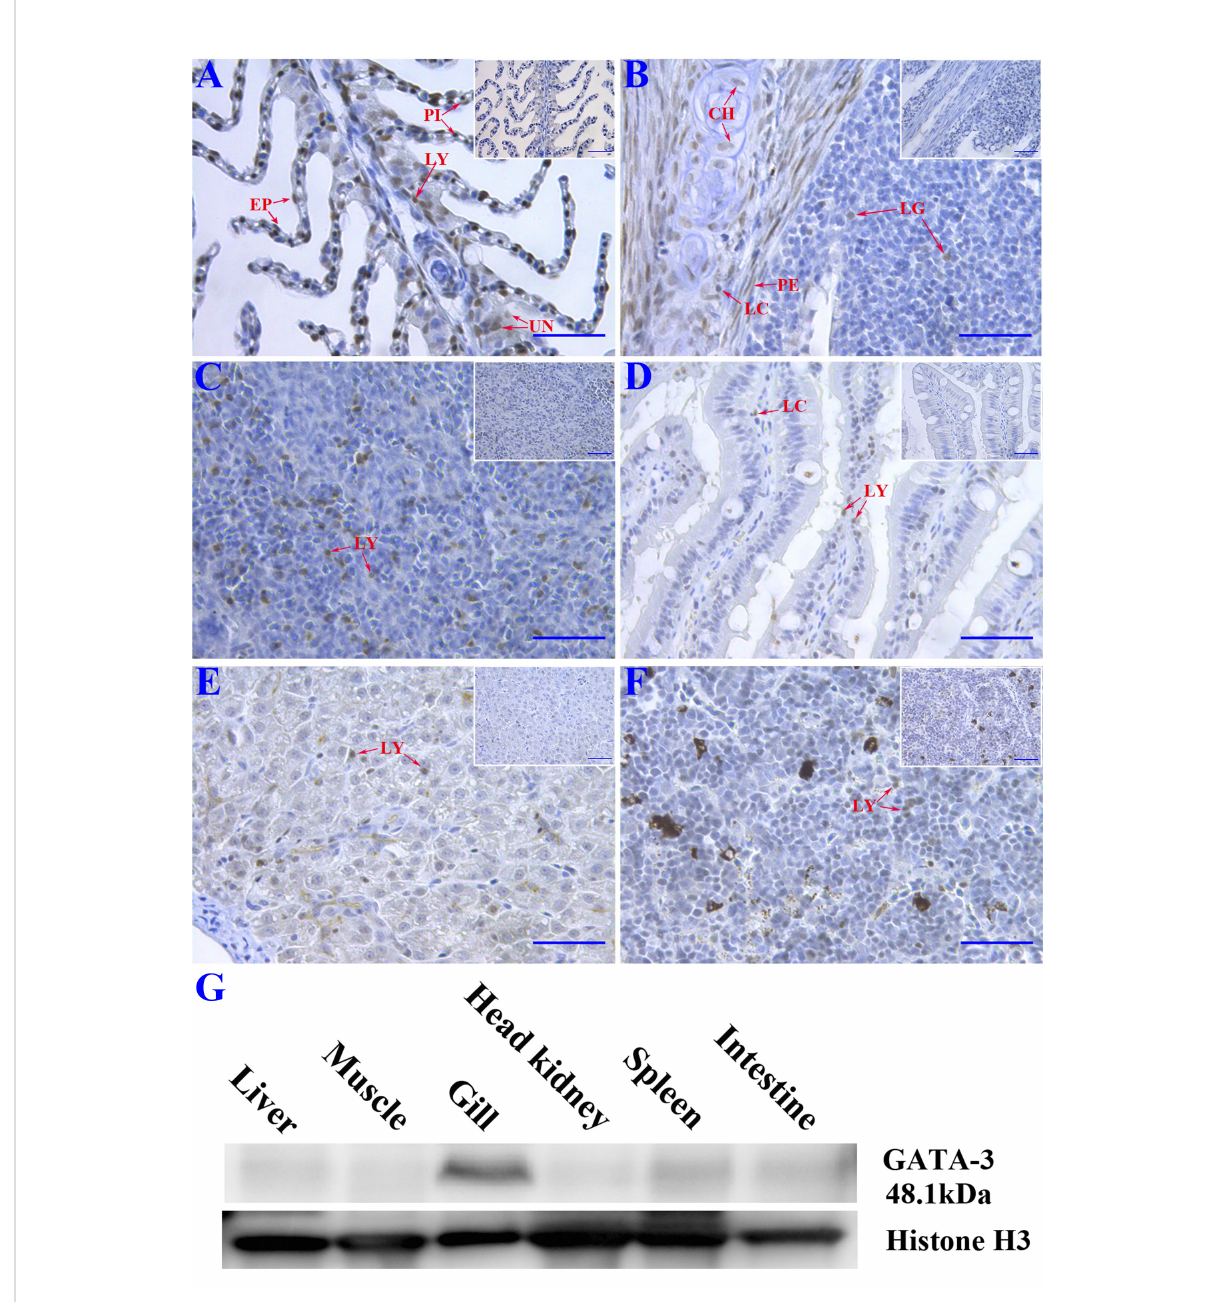
FIGURE 2 Immunohistochemistry study of the distribution of SsGATA-3 proteins in gills (A) , gill-associated lymphoid tissue (GIALT) (B) , spleen (C) , intestine (D) , liver (E) , and head kidney (F) . PI: pillar cell; LY: Lymphocyte-like cell; EP: Epithelial cell; UN: undifferentiated basal cell; CH: chondrocyte; LC: Lymphocyte-like cell in the capillary vessel; PE: perichondrial cell; LG: Lymphocyte-like cell in GIALT. Micrographs displayed in the box show negative controls. Bar=50 m m. (G) Western blot showing the distribution of endogenous SsGATA-3 in different tissues. Anti-histone 3 was used for loading